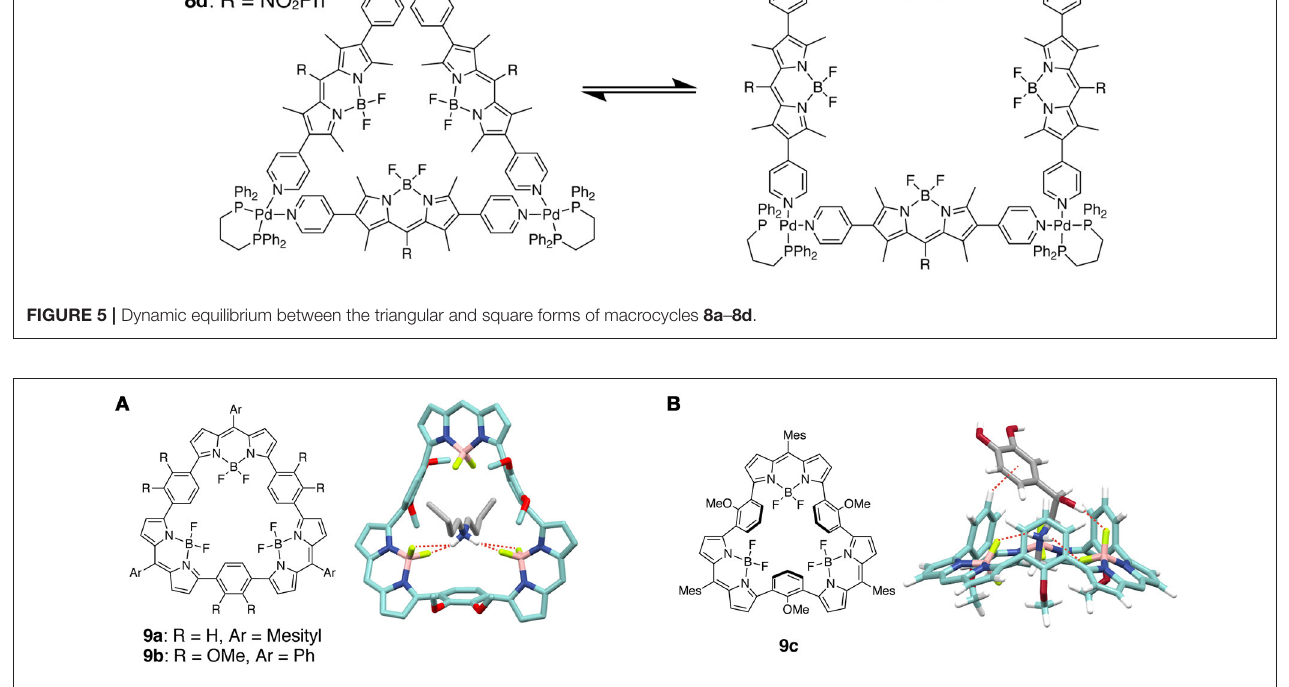
FIGURE 6 | (A) (left) Chemical structure of macrocyclic BODIPY trimers 9a,b . (right) Structure of pseudorotaxane of 9b and a dibutylammonium cation determined by X-ray crystallography. Hydrogen bonds between fluorine atoms of 9b and hydrogen atoms of the dibutylammonium cation are shown as dashed lines. Phenyl groups in 9b , counter anions, hydrogen atoms, and solvent molecules are omitted for clarity. (B) (left) Chemical structure of bowl-shaped BODIPY macrocycle 9c . (right) Structure of pseudorotaxane of 9c and adrenaline obtained by DFT calculations. Intermolecular interactions between adrenaline and 9c are shown as dashed lines. Mesityl groups are omitted for clarity. Adapted with permission from Nakamura et al. (2016). Copyright 2016 Wiley-VCH Verlag GmbH & Co. KGaA, Weinheim.